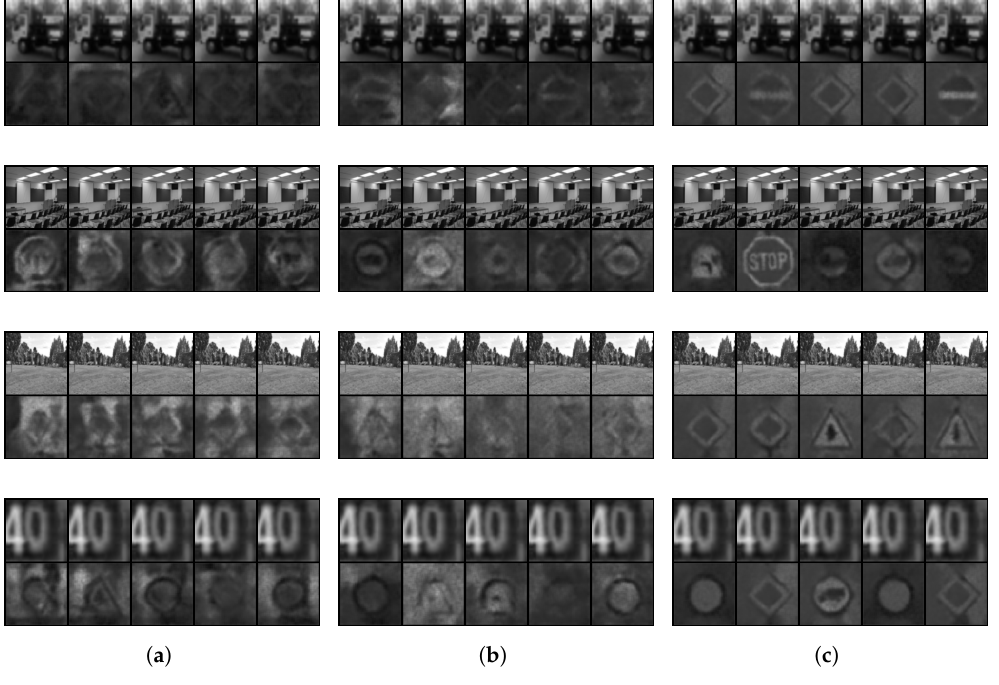
Figure 13. Comparison of OOD images (first row) with the corresponding reconstructions (second row) for several inferences when dropout is enabled. The results are for different autoencoder models for different datasets: CIFAR10 (first block), LSUN (second block), Places365 (third block) and SVHN (fourth block). We either used the triplet loss (TAE), the second variation of the PIRL (II-AE) or just the vanilla reconstruction loss (AE). ( a ) MC-AE. ( b ) MC-TAE. ( c ) MC-II-AE (Ours).